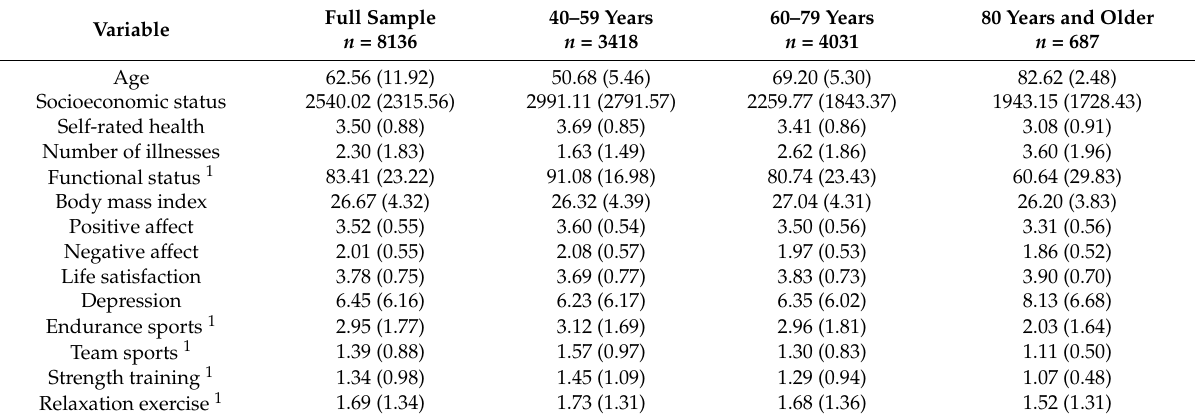
Table 1. Means (and Standard Deviations) of Variables of Interest.